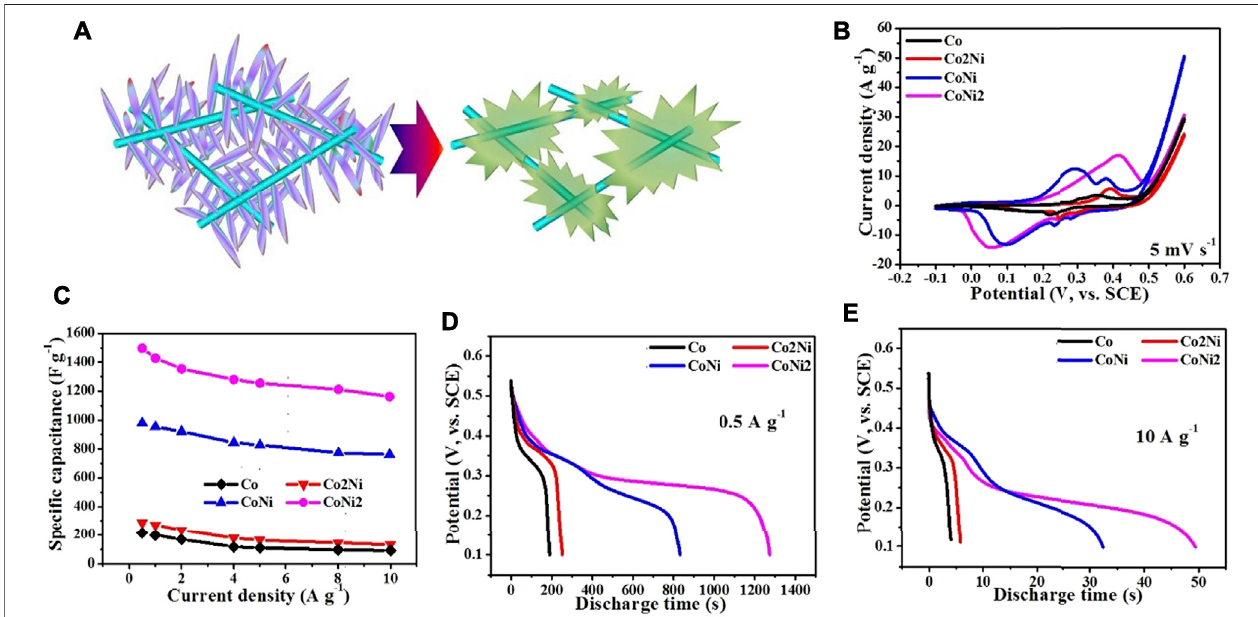
FIGURE 7 | (A) Sketch map of the electrochemical conversion from CoNi2 basic carbonate to relative hydroxide; The electrochemical performance of converted Co/Ni hydroxide/CNT paper composite electrodes with different Co/Ni ratios: CV curves at 5 mV s − 1 (B) ; rate performance (C) ; discharging curves at 0.5 A g − 1 (D) and 10 A g − 1 (E) .